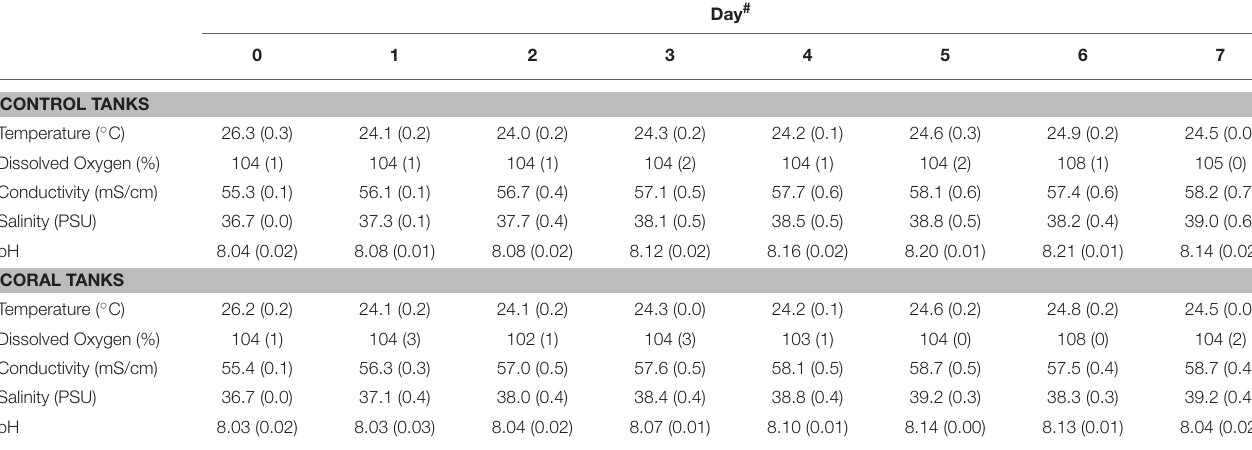
TABLE 1 | Geochemical measurements in tanks.*